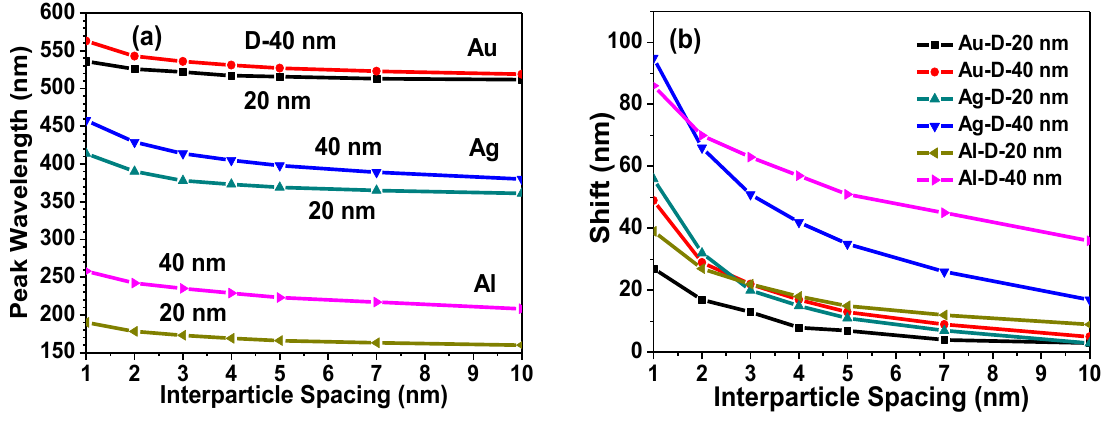
Figure 3: (a) Variation of dipole resonance wavelength of Au, Ag and Al homo-dimer with interparticle spacing. (b) The LSPR wavelength shift of homo-dimer nanostructure wrt isolated nanosphere with interparticle spacing. The particle size is 20 nm and 40 nm.